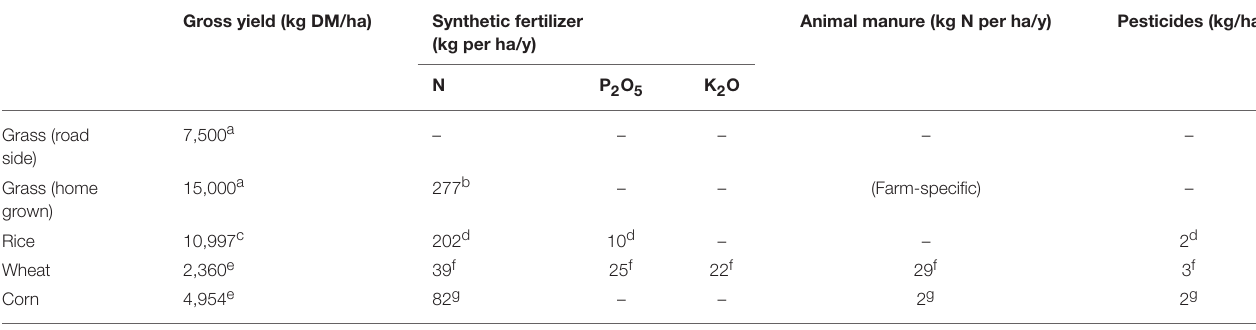
TABLE 2C | Assumed crop yields, fertilizer use, and pesticide use. Gross yield (kg DM/ha) Synthetic fertilizer (kg per